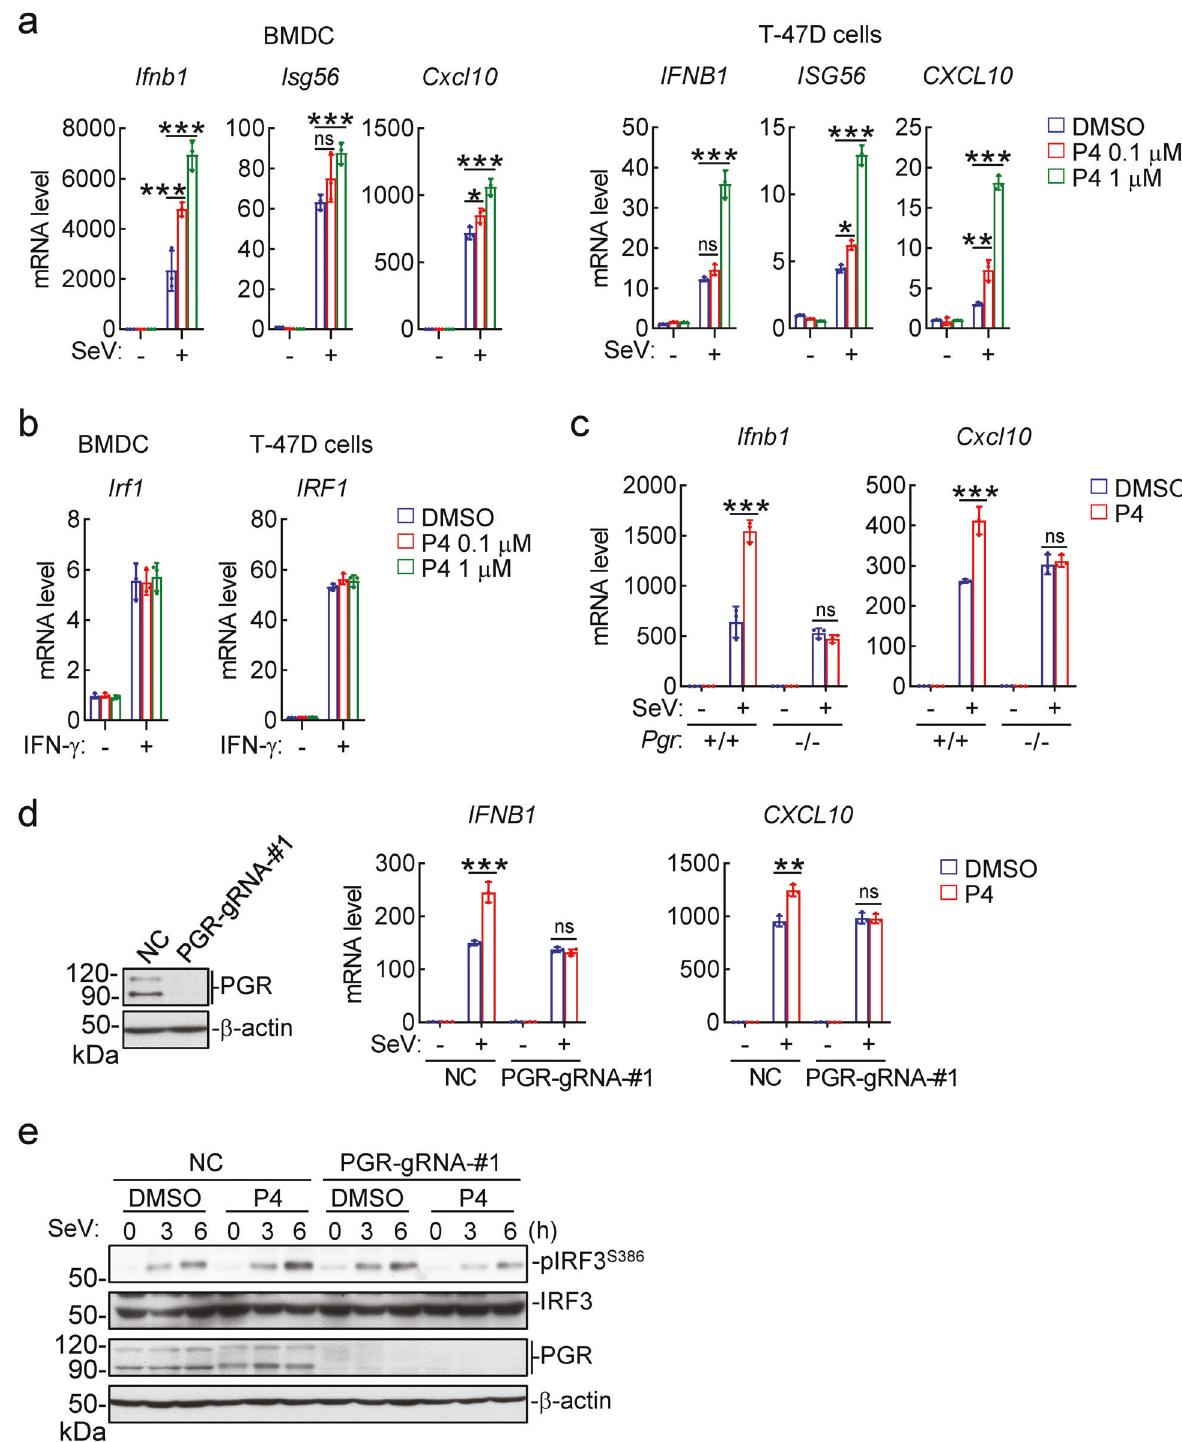
Fig. 3 The progesterone-PGR axis promotes innate antiviral signaling. a Effects of progesterone on transcription of antiviral genes. BMDCs or T-47D cells were treated with the indicated doses of P4 for 1 h and then infected with SeV for 6 h before qPCR analysis of mRNA levels of the indicated antiviral genes. b Effects of progesterone on IFN- γ -induced transcription of IRF1 gene. BMDCs or T-47D cells were treated with the indicated doses of P4 for 1 h and then stimulated with IFN- γ (100ng/ml) for 6h before qPCR analysis of IRF1 mRNA level. c Effects of progesterone on transcription of antiviral genes in Pgr + / + and Pgr − / − BMDCs. Pgr + / + and Pgr − / − BMDCs were treated with P4 (1 μ M) for 1h and then infected with SeV for 6h before qPCR analysis of mRNA levels of the indicated genes. d Effects of progesterone on transcription of antiviral genes in PGR-knockout cells. The control and PGR-knockout T-47D cells were treated with P4 (1 μ M) for 1 h and then infected with SeV for 6h before qPCR analysis of mRNA levels of the indicated genes. e Effects of progesterone treatment on virus-induced activation of IRF3 in control and PGR-knockout T-47D cells. The control and PGR-knockout T-47D cells were treated with P4 (1 μ M) for 1h, and then left uninfected or infected with SeV for the indicated times before immunoblotting analysis with the indicated antibodies. Data shown in a-d are mean ±SD ( n = 3) from one representative experiment, which was repeated for at least two times with similar results. * P <0.05; ** P < 0.01; *** P < 0.001 Signal Transduction and Targeted Therapy (2022)